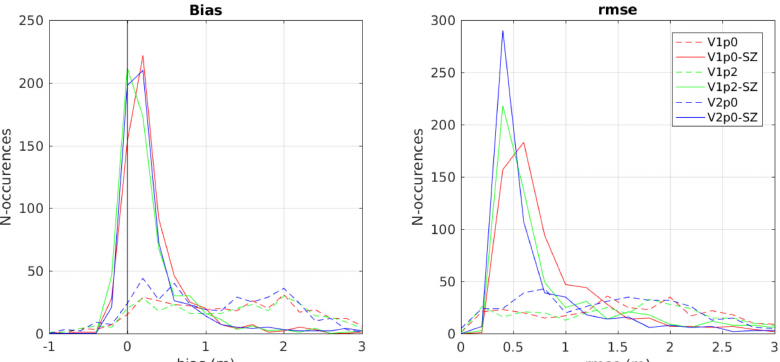
Figure 18. Error bulk statistics binned by depth. Bin depths are plotted at the mean bin depth. Algorithm versions are indicated in the legend. Coverage is omitted, since all versions have been forced to use the V2.0 coverage.